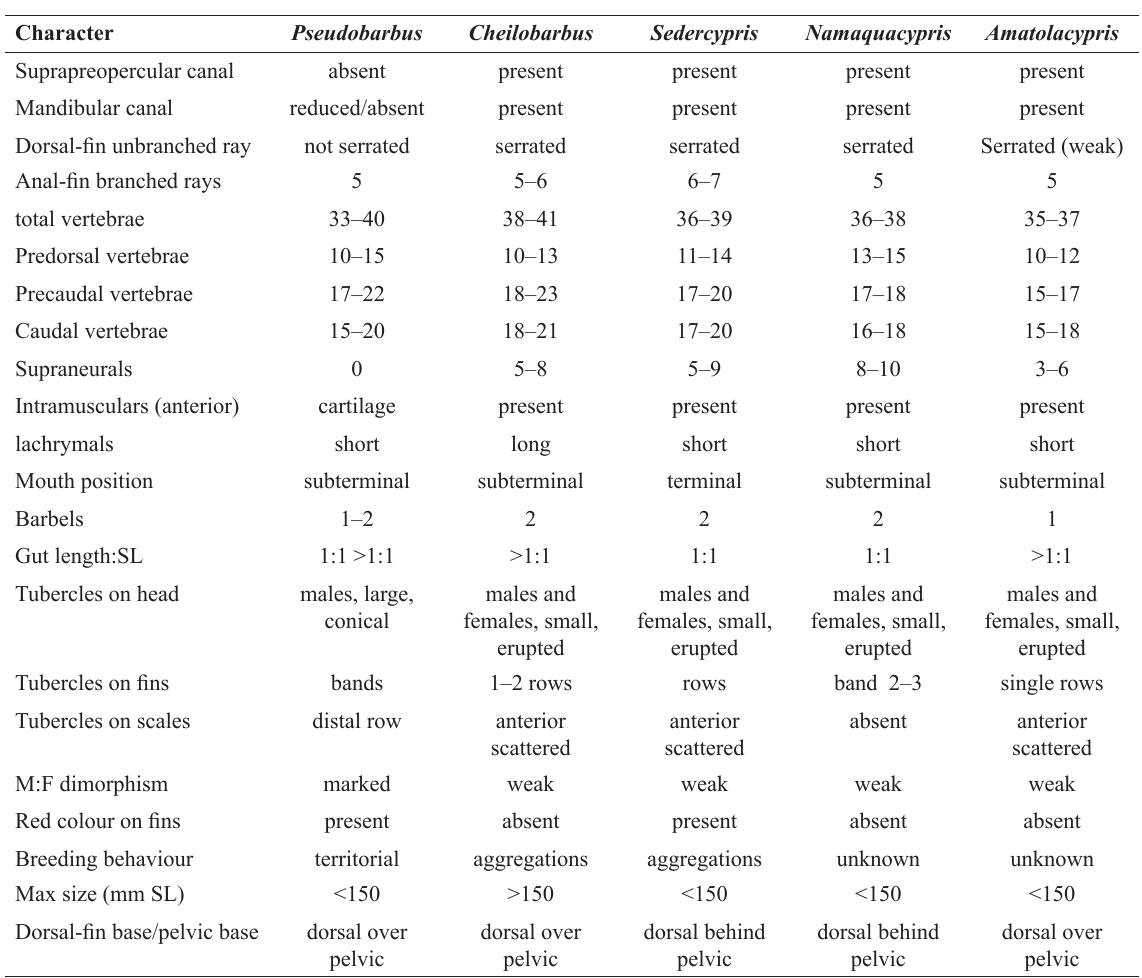
Table 1. Summary of character states of tetraploid cyprinine genera from southern Africa. Data from Skelton